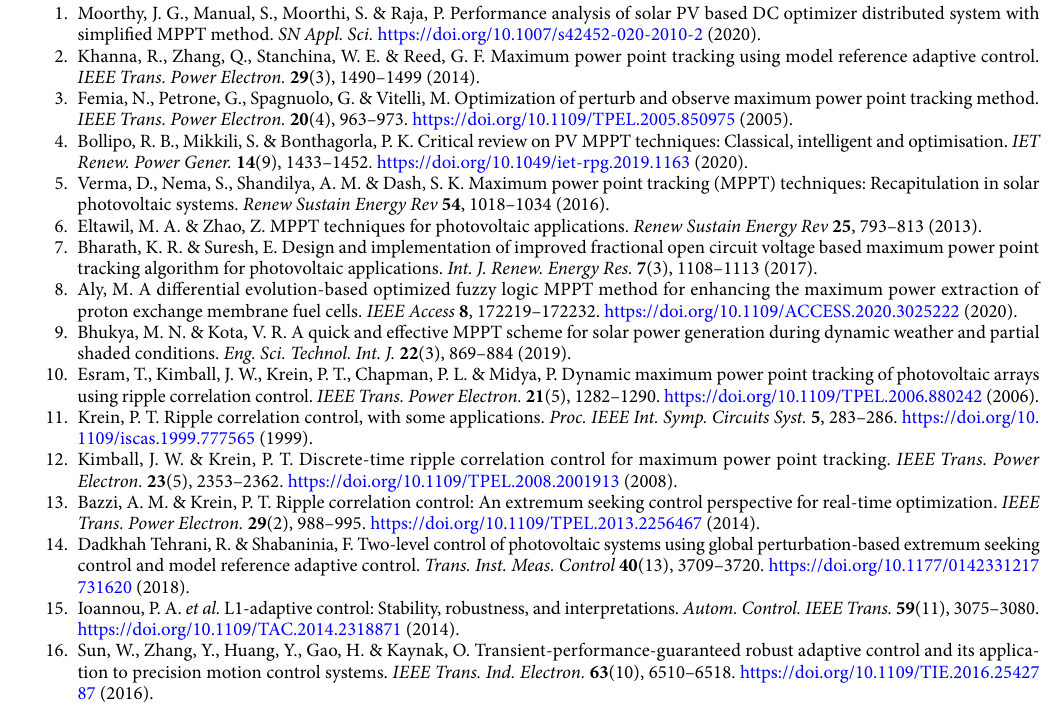
tracking algorithm for photovoltaic applications. Int. J. Renew. Energy Res. 7 (3), 1108–1113 (2017). 8. Aly, M. A differential evolution-based optimized fuzzy logic MPPT method for enhancing the maximum power extraction of